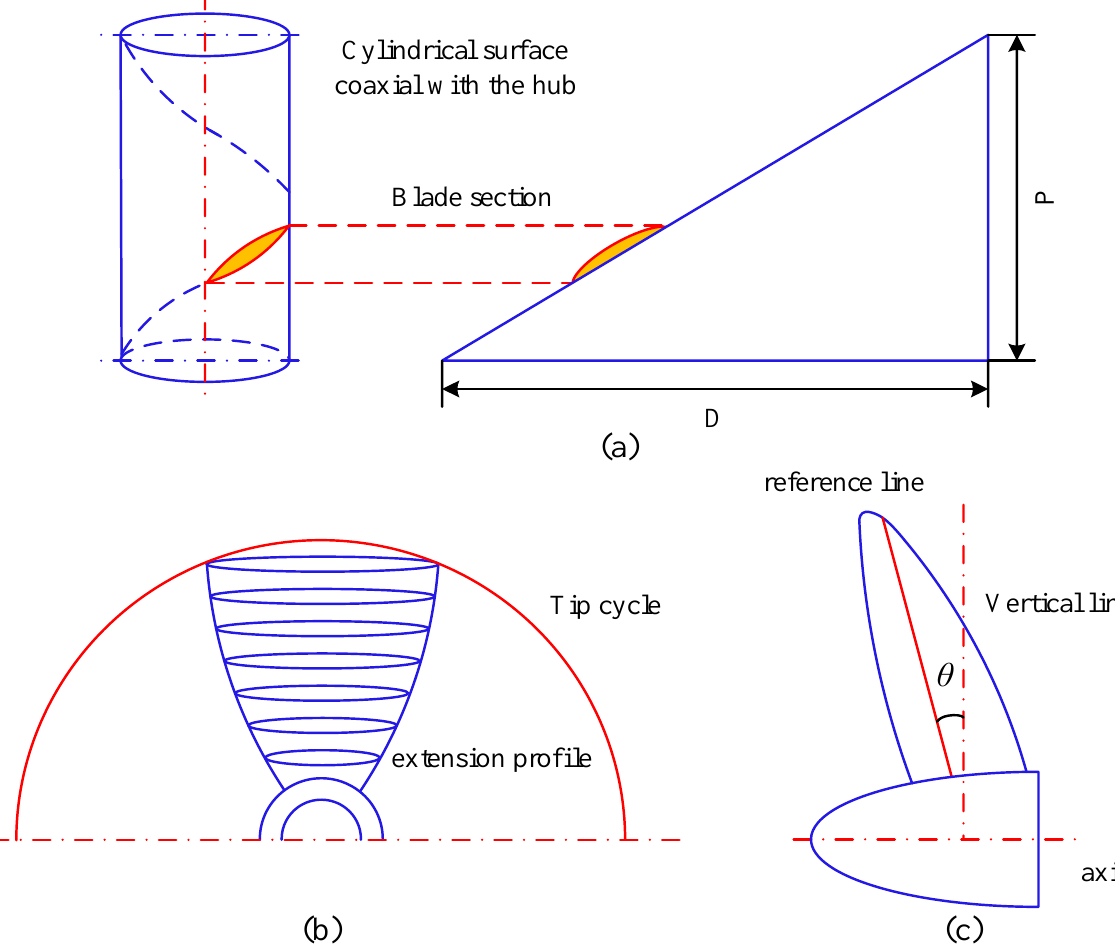
Figure 7. Geometric representation of the optimization parameters: ( a ) pitch ratio, ( b ) disk ratio and ( c ) rake angle.